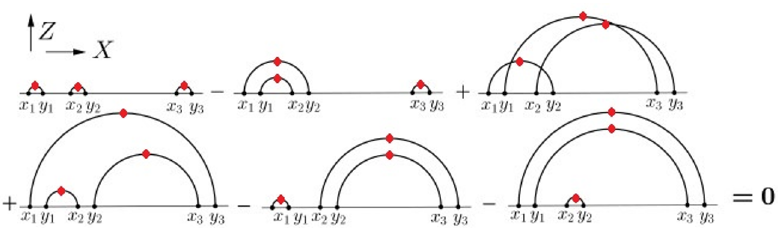
= p + , the map (2.10) implies 1 2